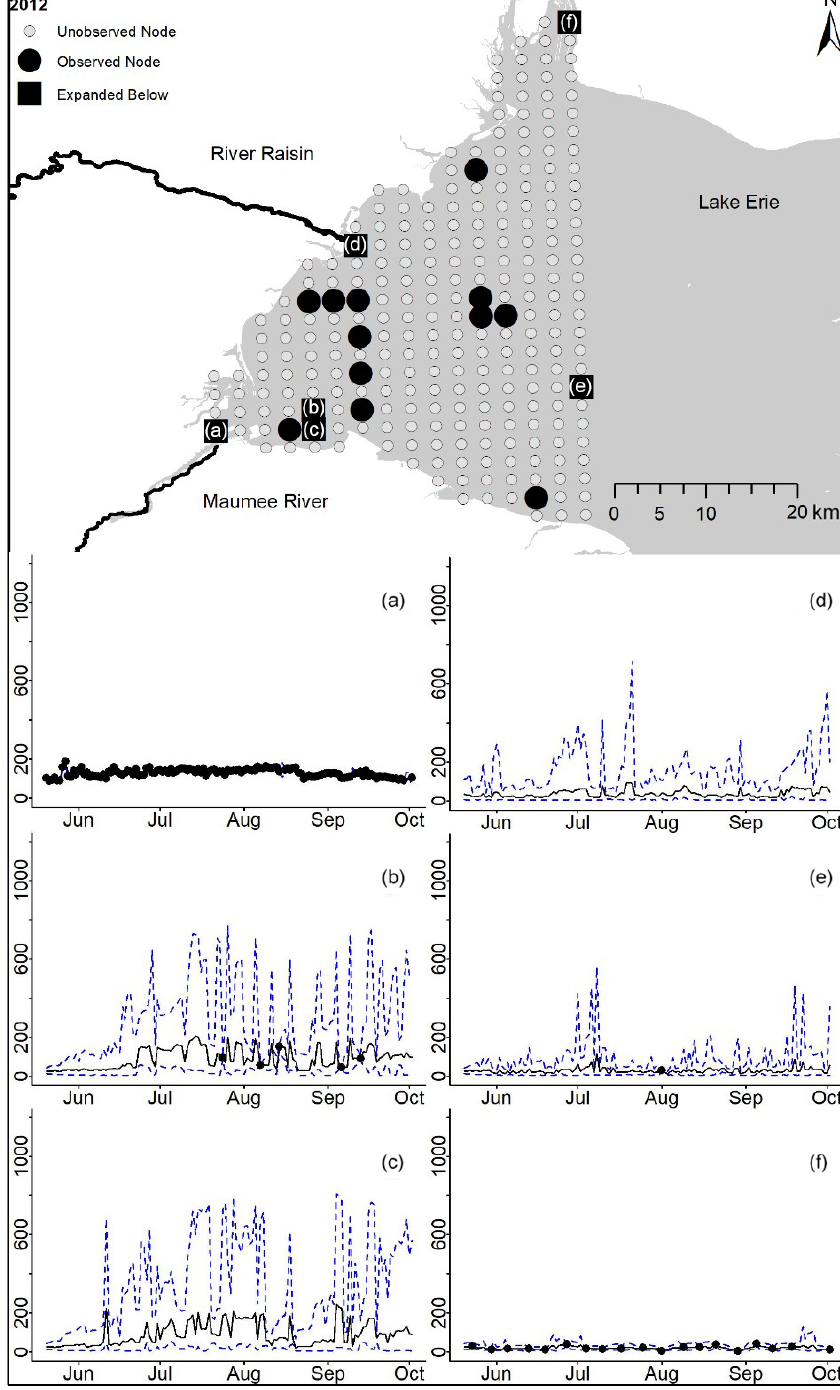
Figure D5. For 2012 the total phosphorus concentrations (µgL − 1 ) at observed and unobserved nodes were estimated from the model posterior samples. Mean (solid black line) and 95%PI (dashed blue line) for the model posterior samples of each node at every day for (a) the Maumee River, (b, c, e, f) western Lake Erie nodes, and (d) the Raisin